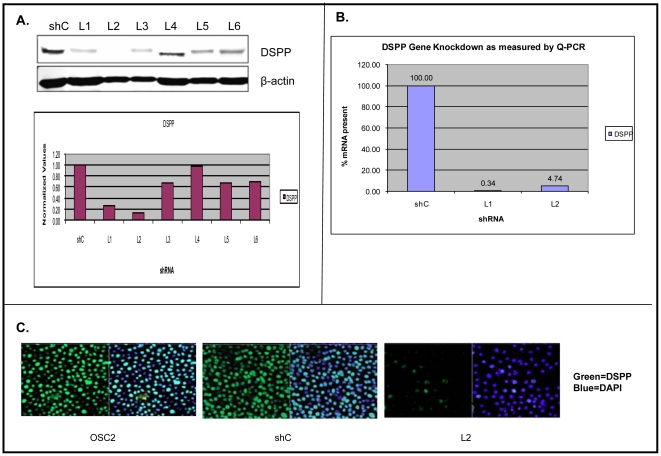
Generation of stable DSPP-silenced OSC2 cell lines.Stable lines selection of lentiviral-transduced shRNA was accomplished via puromycine selection. (A) WB and corresponding densitometric analyses of level of DSPP-silencing following selection of six stable lines show level of silencing ranging from ∼5% (line [L] 4) to ∼95% (L2) compared to scrambled sequence (shC) control. (B) qRT-PCR analysis show significantly reduced DSPP-mRNA in DSPP-silenced L1 (>90%) and L2 (>95%) cells (exhibiting the most knockdown on WB) compared to shC control. (C) Immunfluorescence confocal microscopy verifies DSPP-silencing as significantly reduced DSPP signal (green fluorescence) in L2.